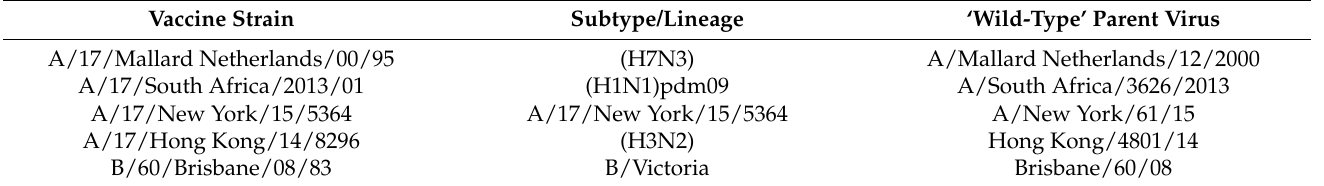
Table 1. Vaccine influenza viruses used to immunize